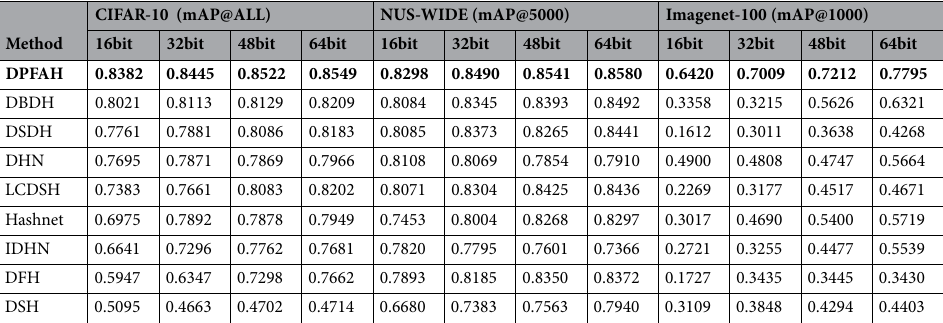
Table 6. mAP for different bit on three datasets. Significant values are in